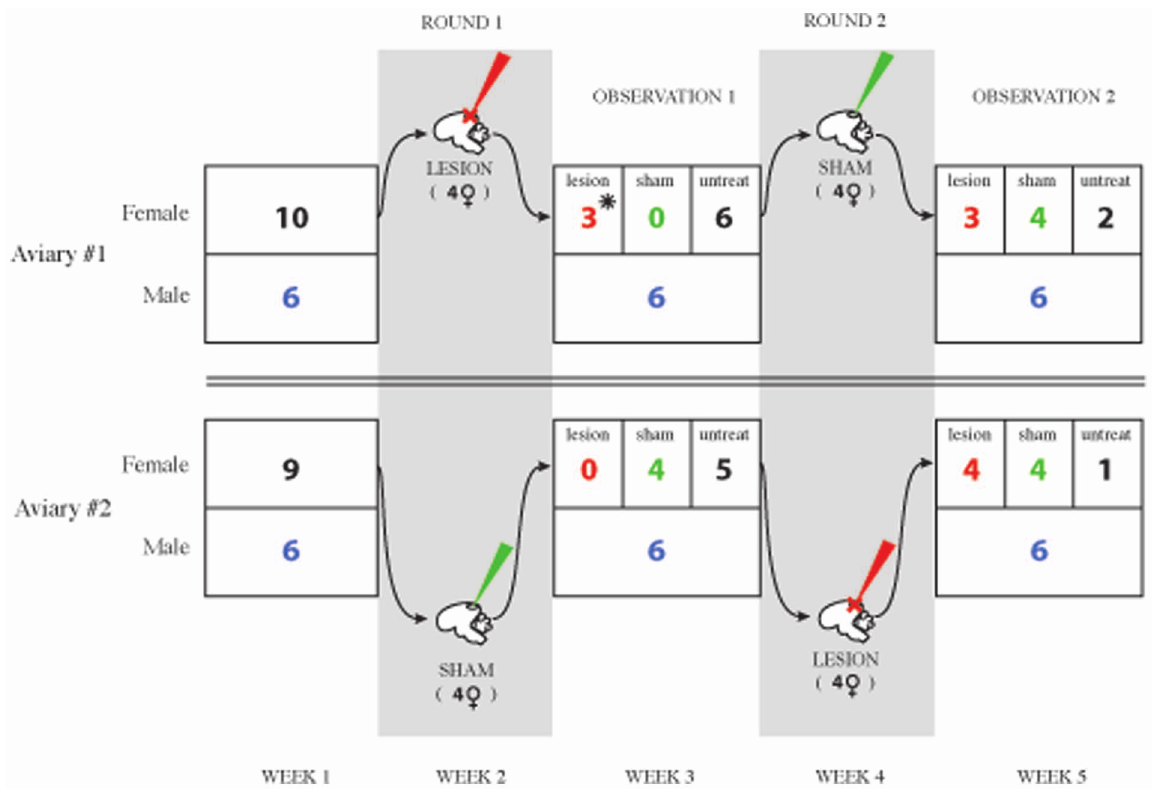
Figure 1. Timing of manipulations in experiment 2. *1 Lesioned female died in surgery in round 1 aviary 1. doi:10.1371/journal.pone.0063239.g001 females (r = .15, NS). Instead, lesioned females produced robust copulatory responses to all of the songs in the playback set.